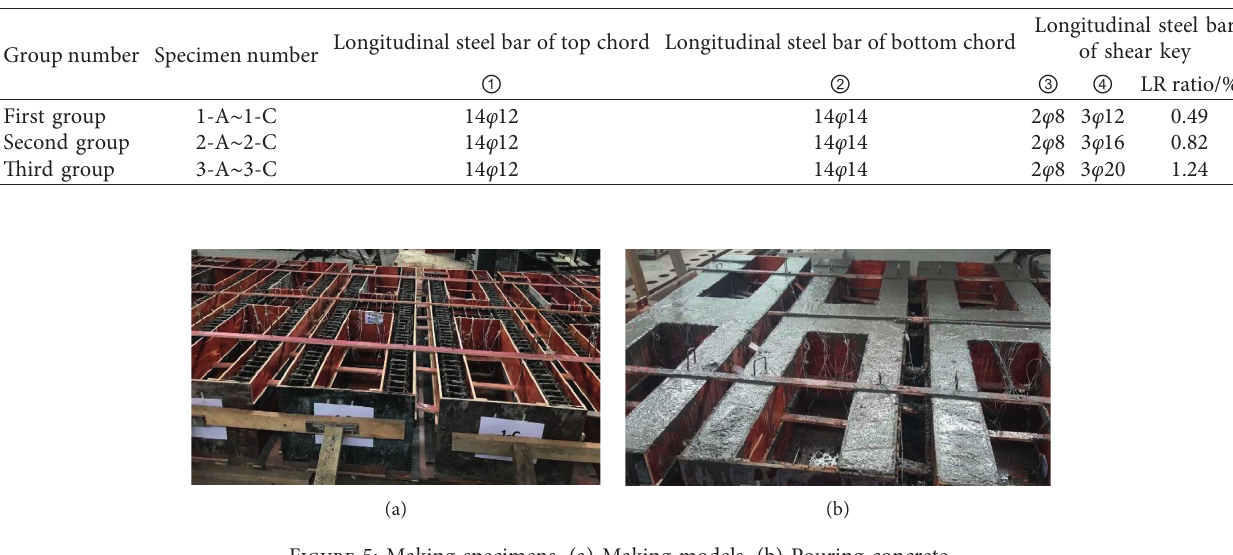
Table 1: Test piece reinforcement